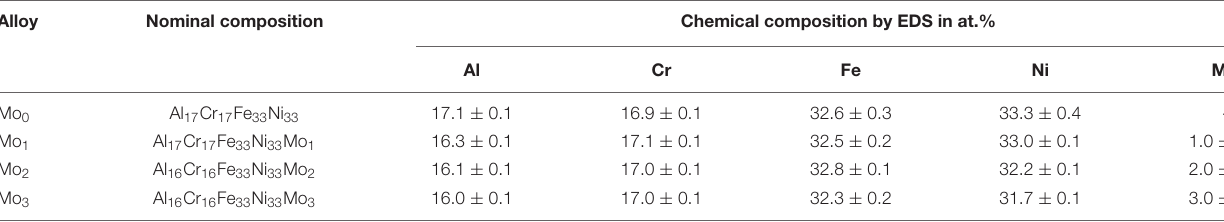
TABLE 1 | Nominal and integral composition of fabricated AlCrFe 2 Ni 2 Mo x samples by EDS (at.%). Alloy Nominal composition Chemical composition by EDS in at.%